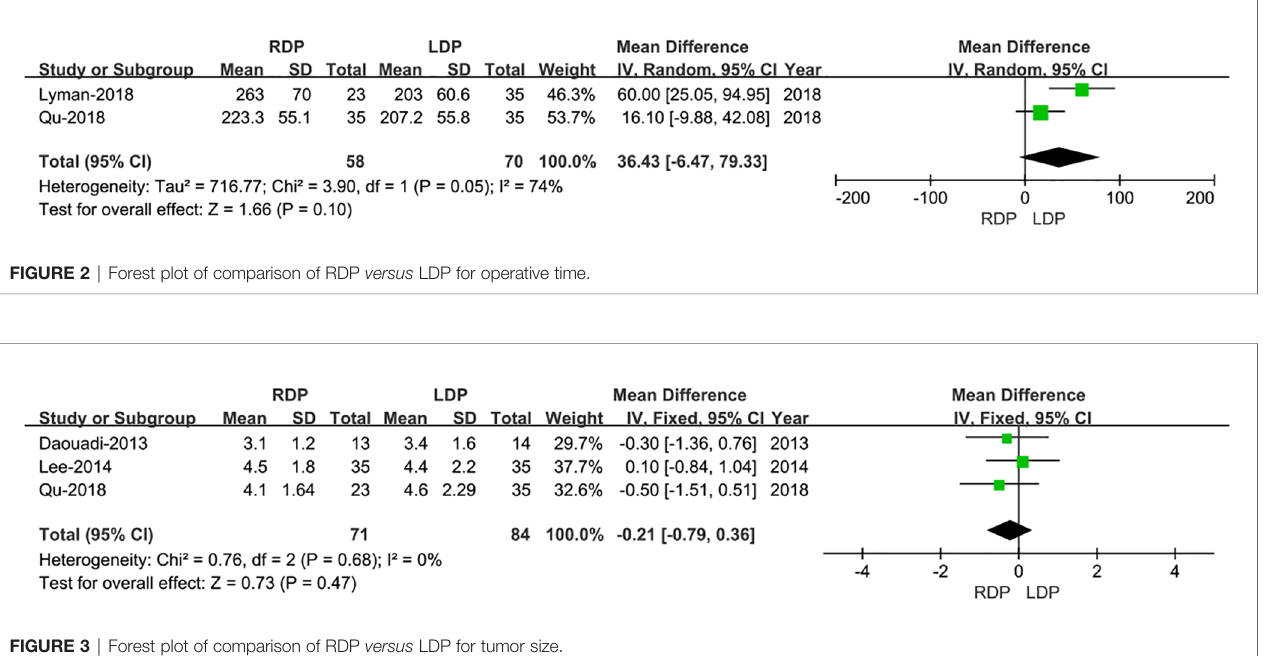
FIGURE 3 | Forest plot of comparison of RDP versus LDP for tumor size.